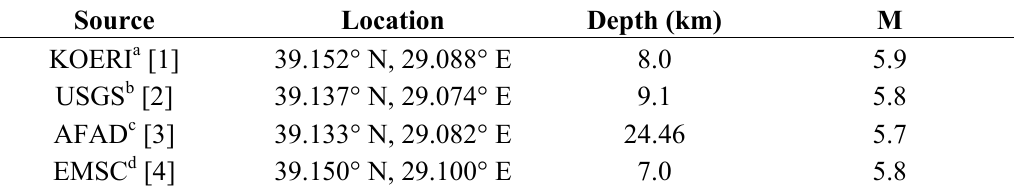
Table 1. Simav earthquake information reported by different